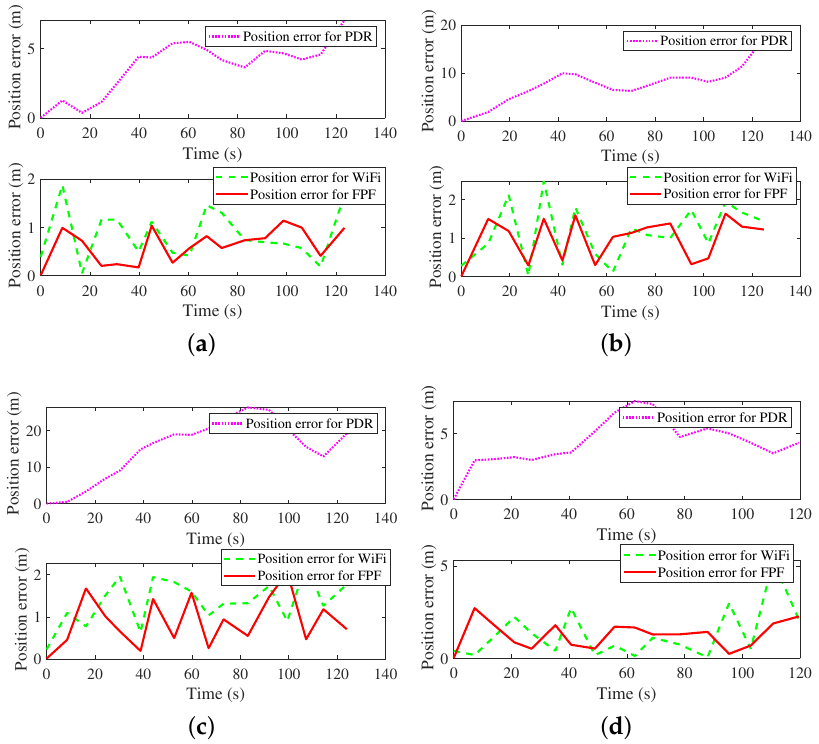
Figure 7. Position errors with different modes. ( a ) Position errors with calling mode. ( b ) Position errors with dangling mode. ( c ) Position errors with handheld mode. ( d ) Position errors with pocketed mode.